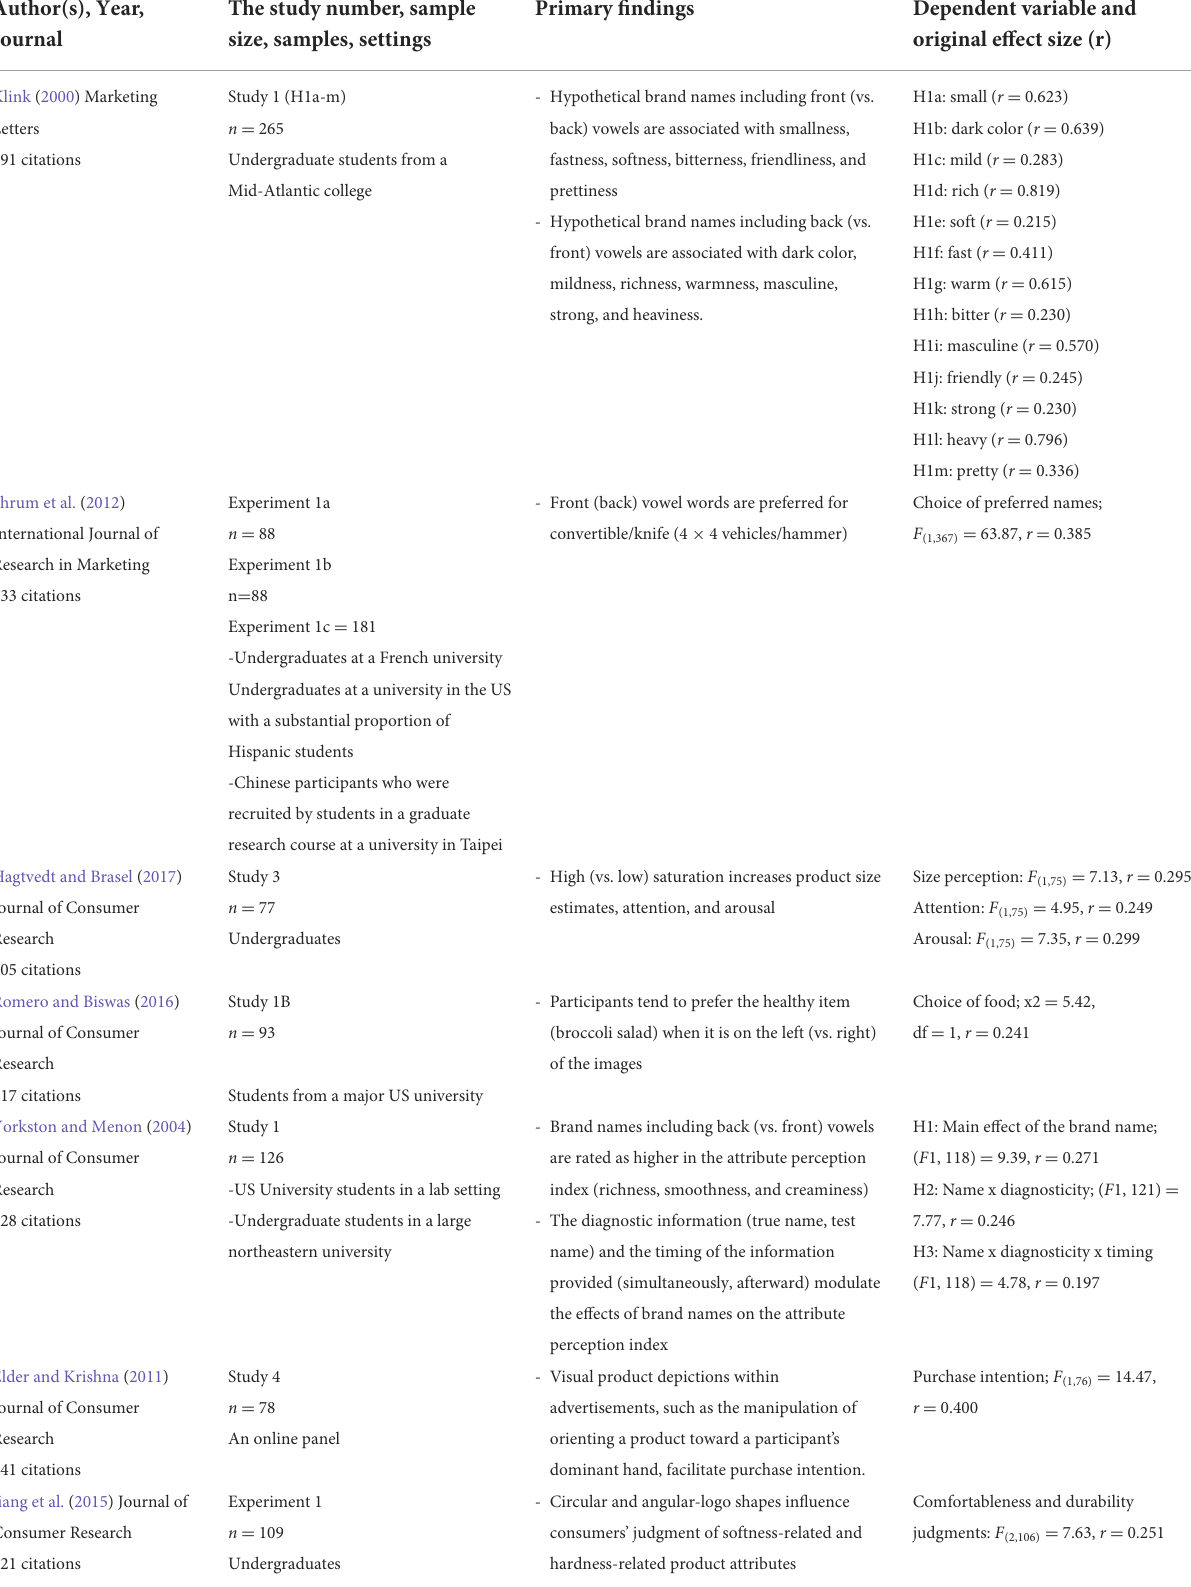
TABLE 1 Summary of previous findings that the current research attempts to